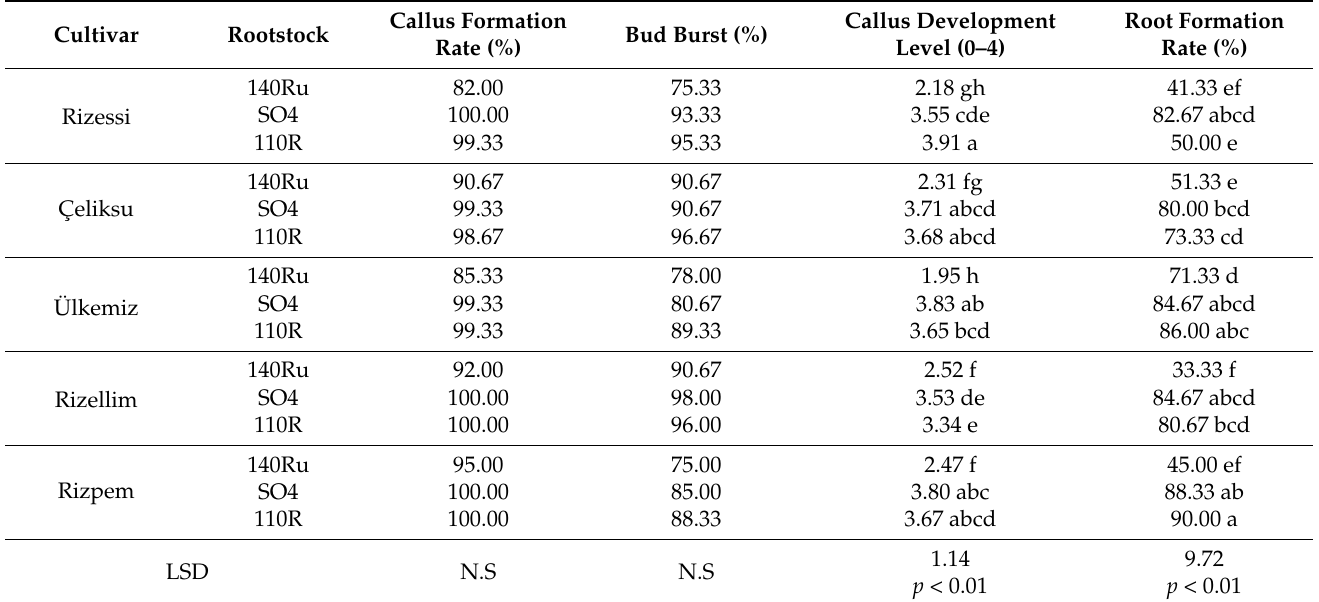
Table 1. Grafting success criteria in foxy grape ( V. labrusca L.) cultivars grafted on different